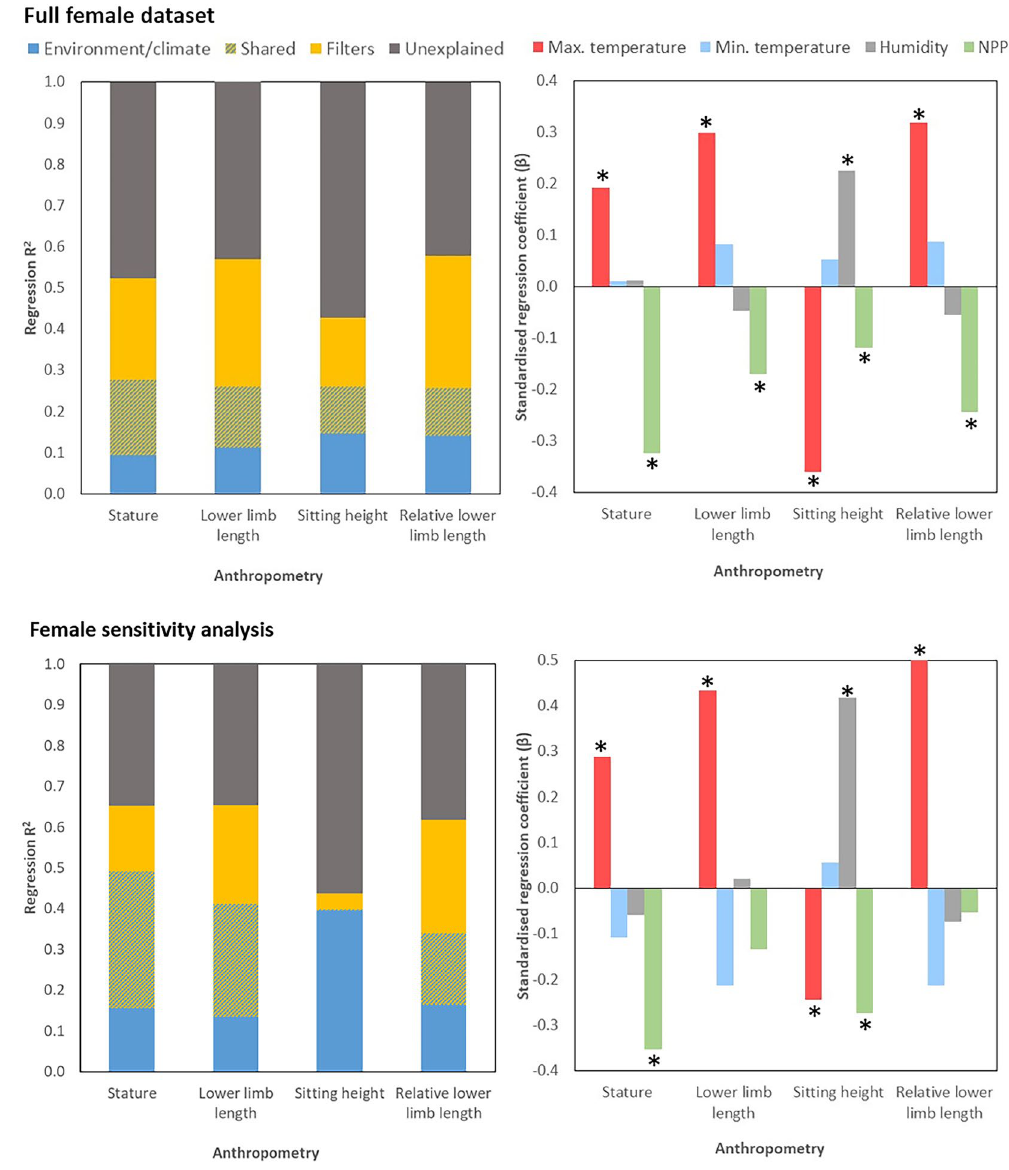
Figure 4. Results from the analysis of relationships between anthropometry and climatic/environmental variables for the female dataset (above: full; below; sensitivity analysis), adjusted for population history using spatial filters. Left: Variation explained by environment/climate, spatial filters, both together, or remaining unexplained by the models. Right: Standardised regression coefficients for environmental/climatic variables in explaining anthropometry, adjusting for population history. NPP net primary productivity. * Denotes p < 0.05 for variable in regression model, of which full details are in Supplementary Tables S7–S8. Above: full sample. Below: sensitivity